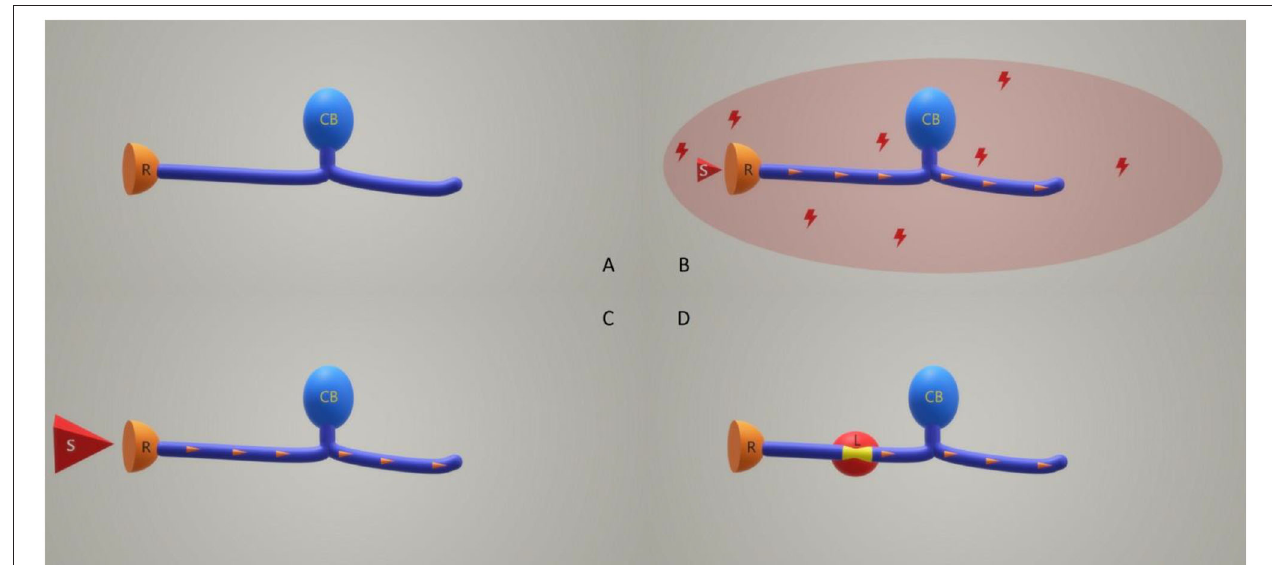
FIGURE 1 | Relation between pain type and sensory neurons functionality. (A) Normal sensory neuron without any stimulus. (B) Nociplastic pain situation: a normal sensory neuron surrounded by a hostile microenvironment is receiving a subliminal stimulus. (C) Nociceptive pain situation: a normal sensory neuron receives a proper magnitude stimulation. (D) Neuropathic pain situation: an injured sensory neuron does not receive any stimulation of the receptors, or the stimuli are insignificant. In (B–D) situations the result is similar: an electrical impulse (orange arrowheads) is created. R, receptor; CB, cellular body; S, stimulus; L, the lesioned area of the sensory